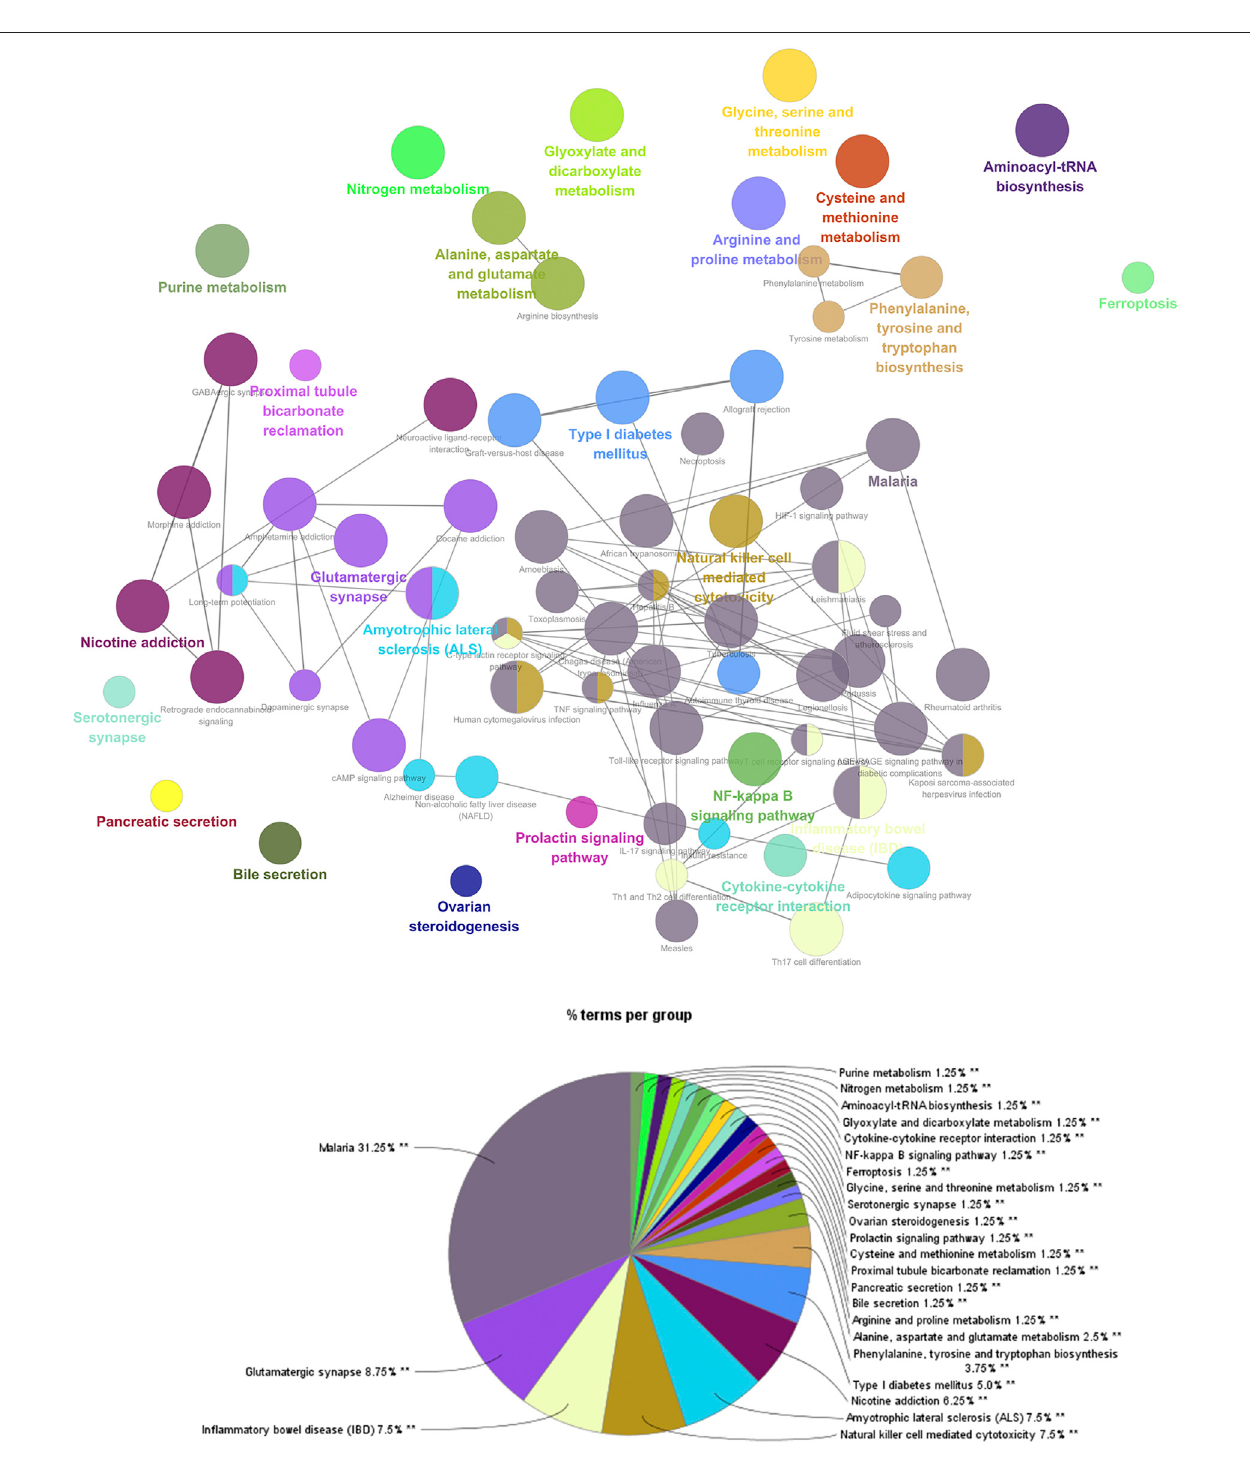
FIGURE 6 | The results of